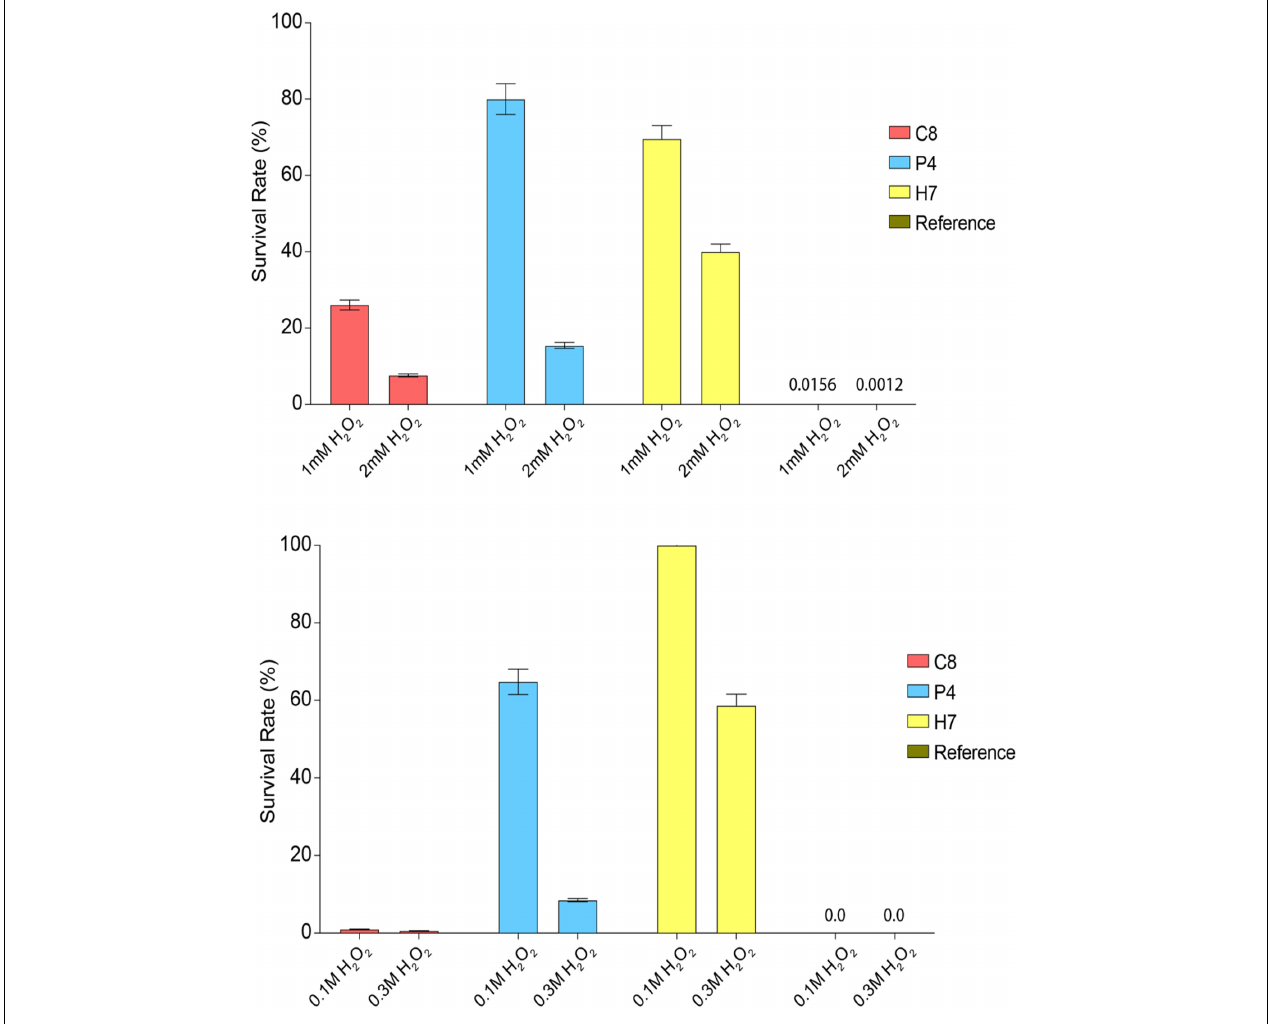
FIGURE 2 | Oxidative stress survival rates of the reference and most resistant strains C8, P4, and H7 obtained from OC, OP, and HP selection approaches, respectively. The cultures were (top figure) continuously exposed to 1 or 2 mM H 2 O 2 or (bottom figure) exposed to 0.1 and 0.3 M H 2 O 2 as pulse oxidative stress. The survival rates (%) were determined upon incubation (72 h, 30 ◦